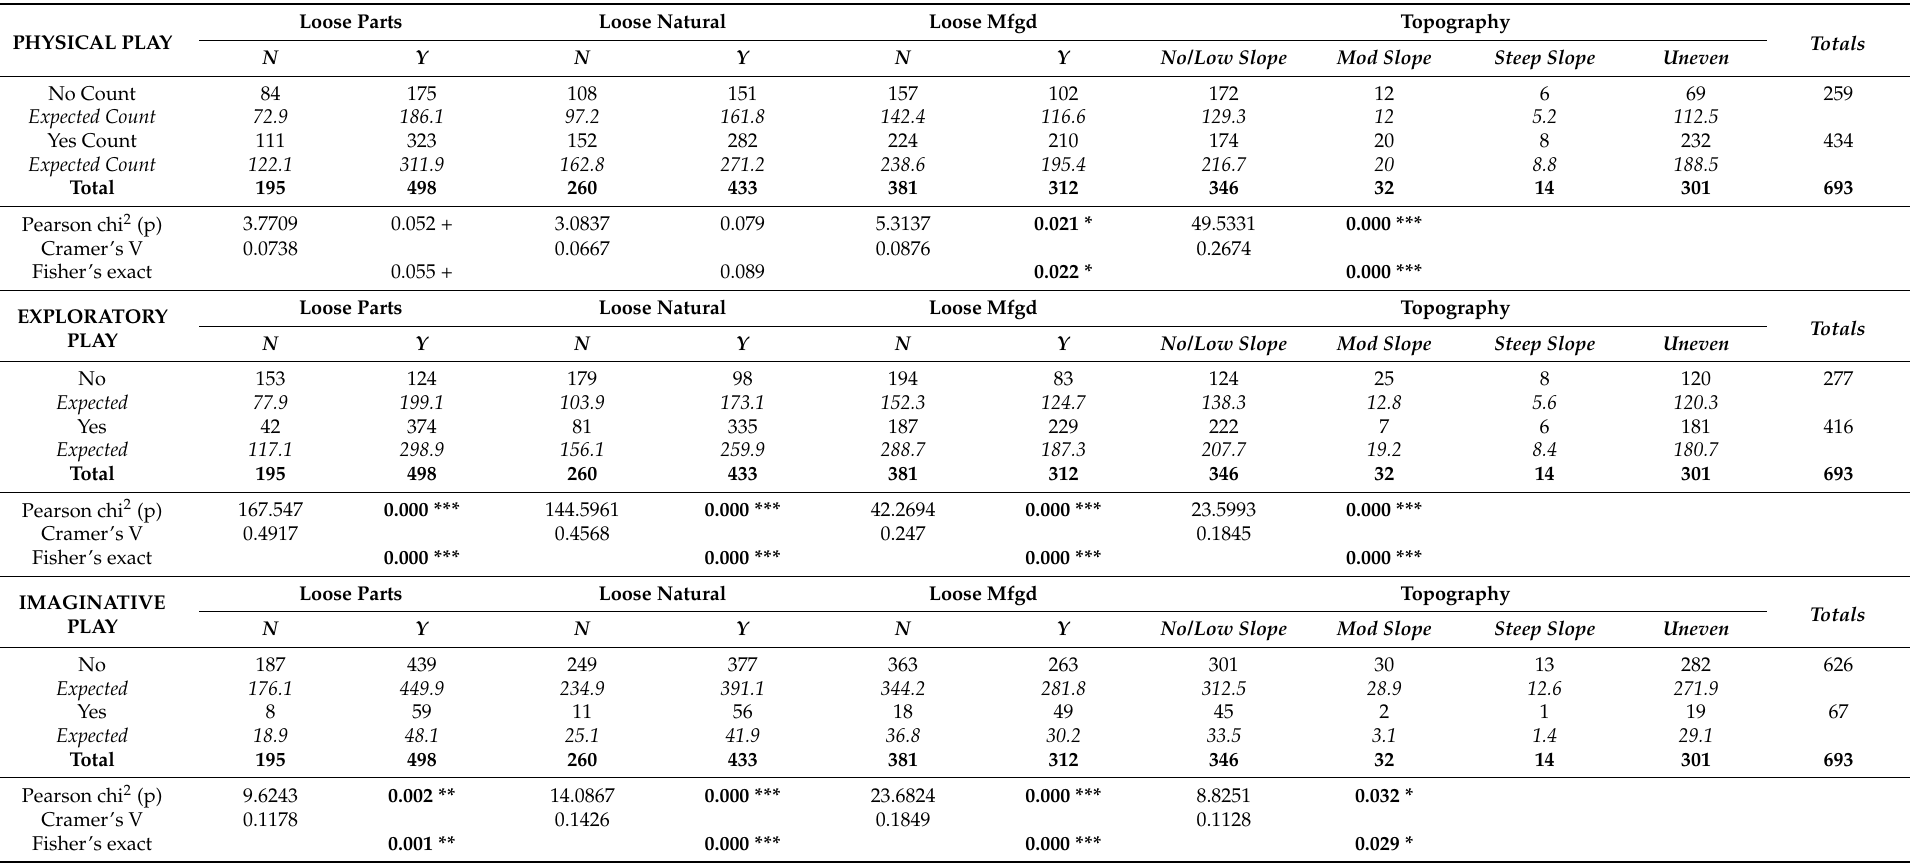
Table 3. Associations with outdoor play types for select environmental variables using Pearson, Chi 2 and Fisher’s exact